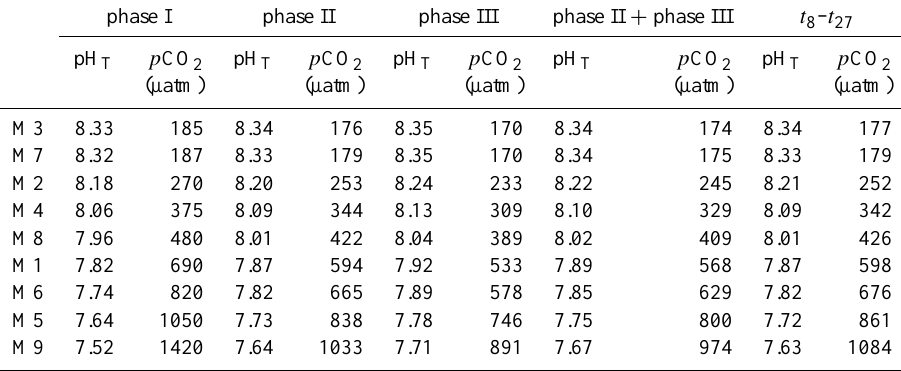
Table 1. Mean values of p CO 2 and pH T (total scale) levels in mesocosms for every phase, post-nutrients period t 14 – t 27 and the overall period t 8 – t 27 . p CO 2 and pH T are calculated from total carbon and total alkalinity using CO2SYS for Matlab (van Heuven et al., 2011) . The dissociation constant for carbonic acid was adopted from Dickson and Millero (1987), for boric acid from Dickson (1990a), for sulfuric acid from Dickson (1990b); CO 2 solubility coefficient was adopted from Weiss (1974).